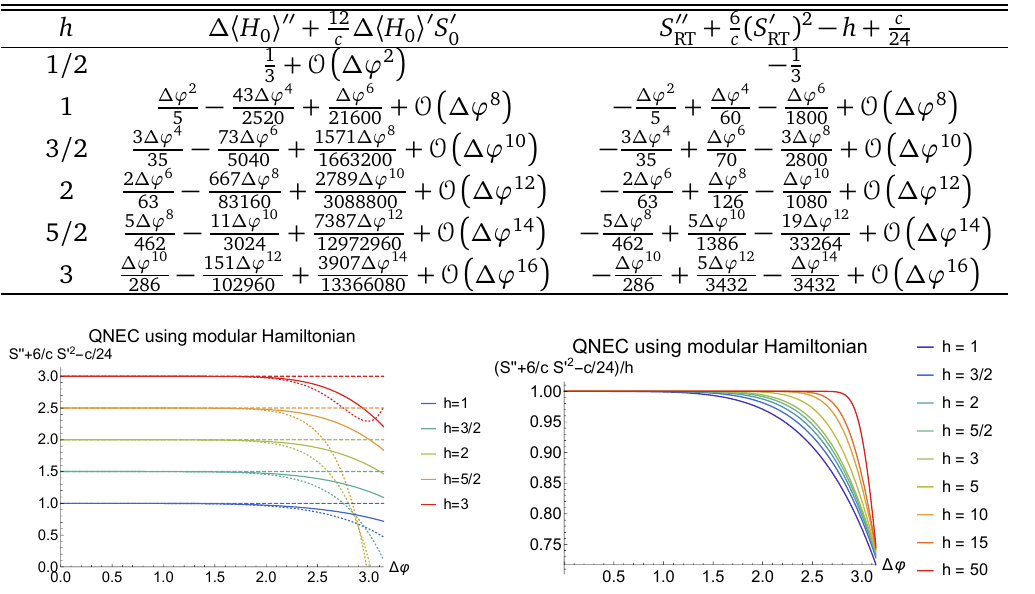
Figure 8: Finite- c corrected QNEC. Left: The solid lines show the right-hand side of QNEC which includes the modular Hamiltonian and the RT extremal surface con- tributions to the EE. The dotted lines show the small ∆ ϕ expansion as computed in Table 1. Dashed lines represent the corresponding values of 2 π ( 〈 T ±± 〉 − c / 24 ) . Right: QNEC non-saturation, rescaled by h . As we see QNEC non-saturation happens at large intervals. For large h the non-saturation appears only for intervals close to the half-space ( ∆ ϕ = π ). We derive in Section 5.4 the result suggested by the right plot, namely that QNEC is gapped by h / 4 at ∆ ϕ = π for large h